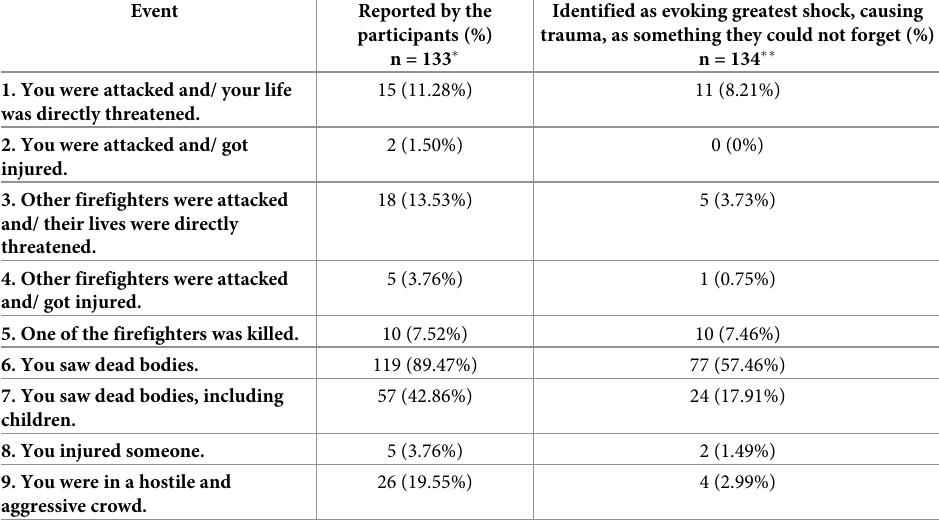
Table 3. Traumatic events as reported by the participants.